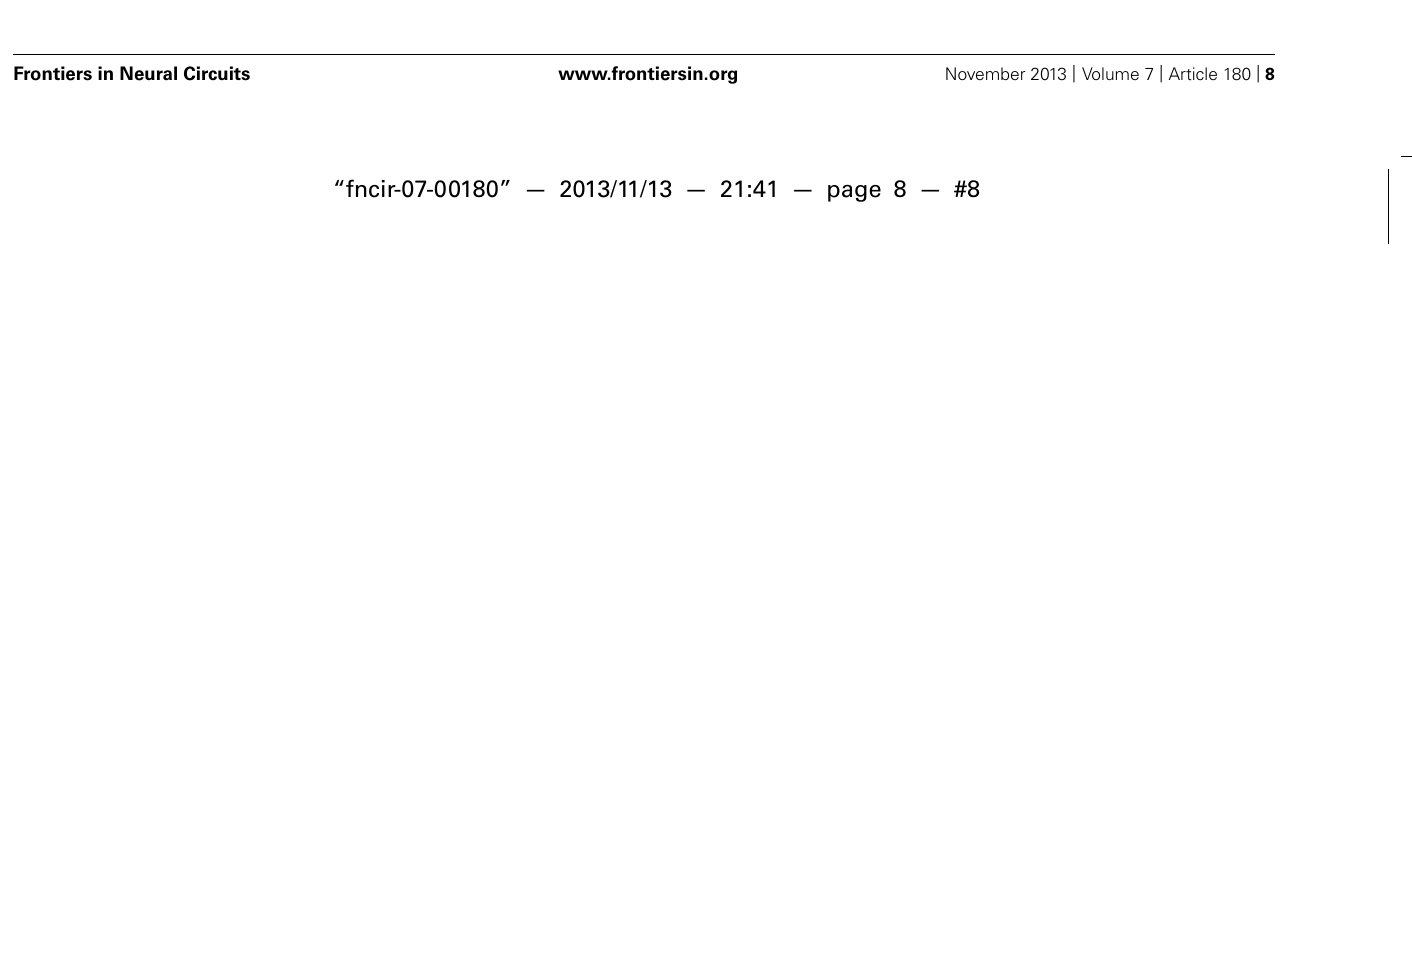
rescued the multiple CF innervation pattern in a single Purkinje cell from a cbln1 − / − mouse.The number of CF–EPSCs induced by different stimulus thresholds (0–200 μ A) was counted.The percentage of Purkinje cells innervated by single CFs in wild-type (WT) mice was significantly higher than that in cbln1 − / − mice 2 days after the injection of a control solution ( + control 2 days; ** p < 0.00001, Fisher’s exact test).There were no significant (ns) difference between control solution and Cbln1 at 2 days after the injection ( + Cbln1 2 days; p > 0.1, Fisher’s exact test). Similarly, there were no significant difference between 2 and 4 days after a Cbln1 injection ( + Cbln1 4 days; p > 0.1, Fisher’s exact